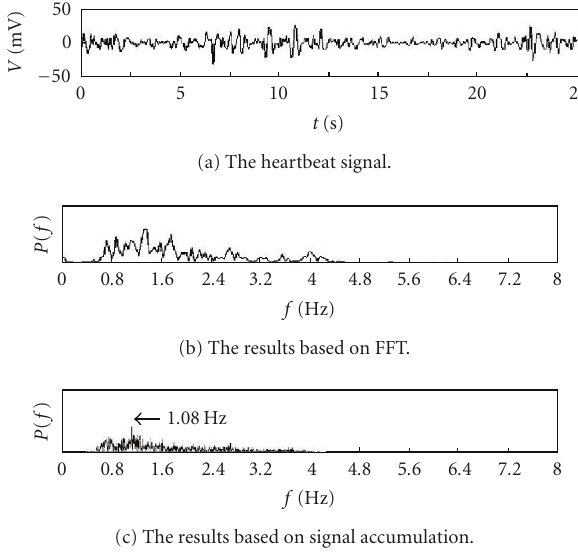
Figure 3: The results using the signal accumulation by